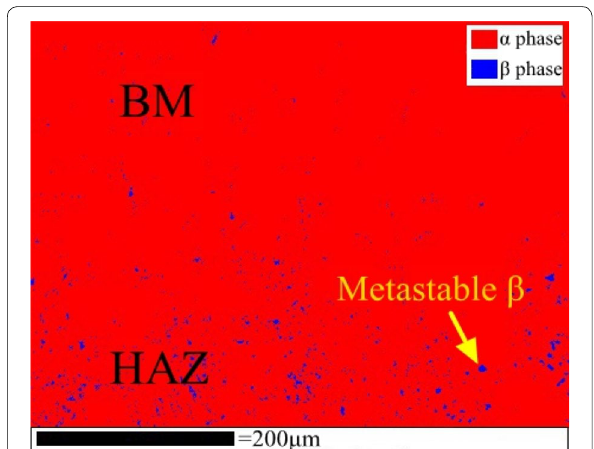
Figure 11 Phase distribution map in HAZ and base material by